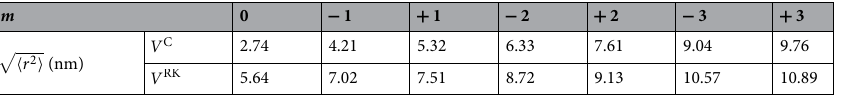
Table 1. Mean exciton diameters of the zero-momentum states with the Coulomb and Rytova–Keldysh potentials with ε s potential the radii must be compared to the film thickness, which is L z = 6 nm .